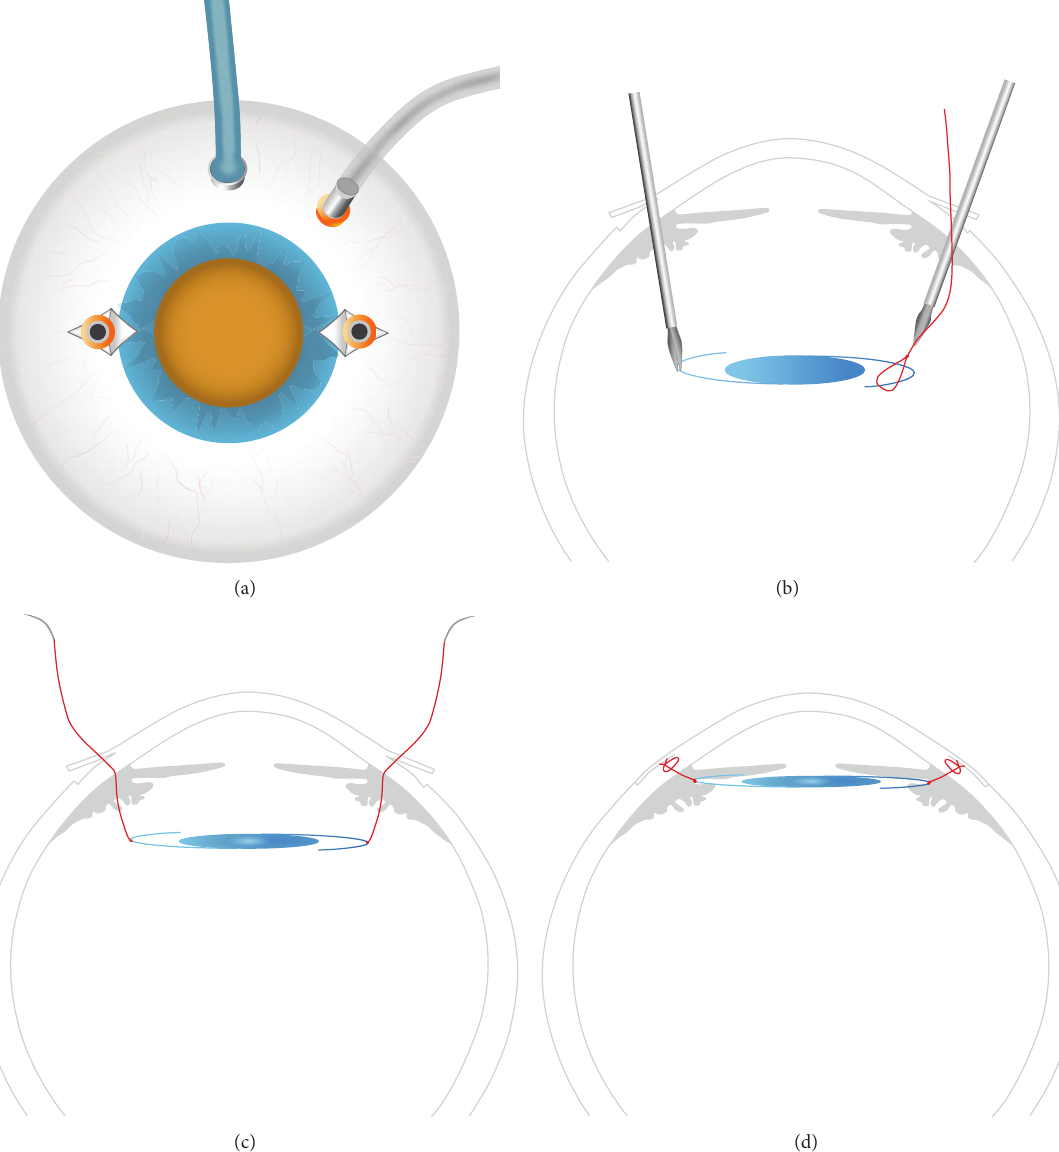
Figure 1: (a) Two scleral limbal-based flaps at 3 and 9 o’clock were created. Three 23-gauge vitrectomy ports were introduced, two passing through the scleral flaps, with an accessory 25-gauge light source introduced at 12 o’clock. (b) After complete vitrectomy, the lens was raised to the middle of the vitreous cavity using two peeling forceps. Each haptic was snared by a previously prepared loop; then the suture was tensed around the middle of the haptic. (c) Once the two haptics of the lens were captured, the lens was repositioned in the sulcus by simply tensing the two sutures. (d) Once the two haptics of the lens were repositioned in the sulcus, the sclerotomies were closed with the same sutures as those holding the